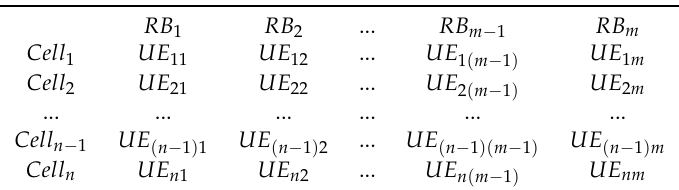
Table 1. Resource allocation